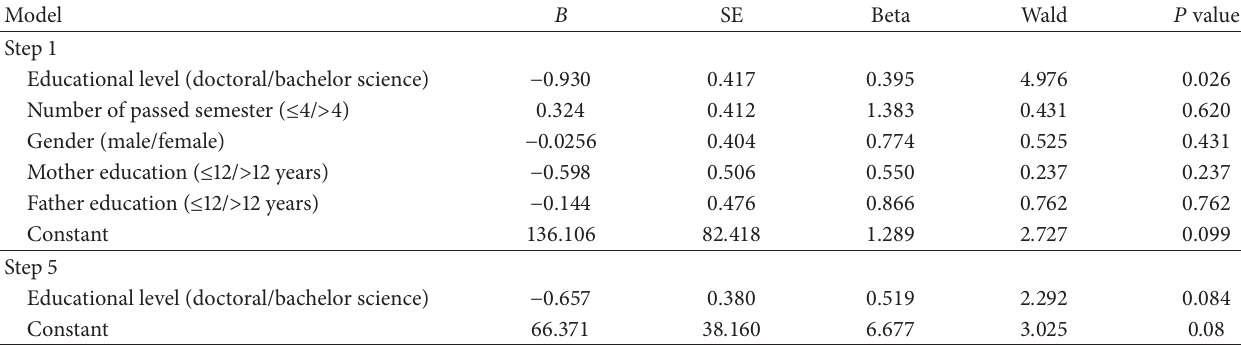
Table 4: The results of multiple analysis of logistic regression (backward) between alexithymia and demographic characteristics of academic